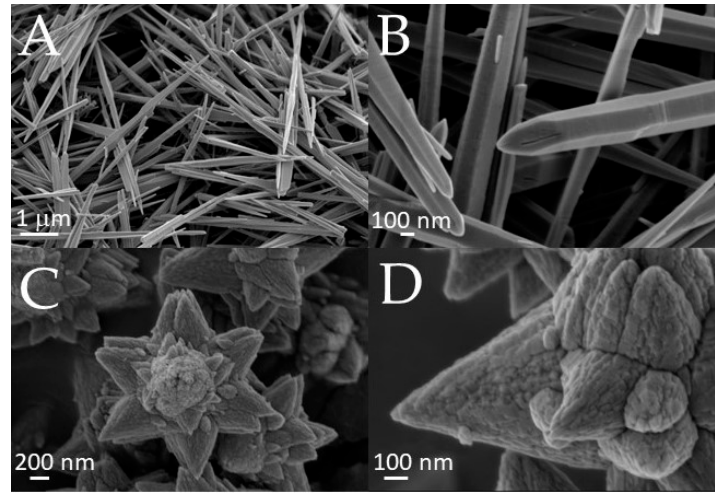
Figure 5. SEM micrographs of ZnO morphologies: ( A , B ) long needles (ZLN) and ( C , D ) nanoflowers (ZFL).